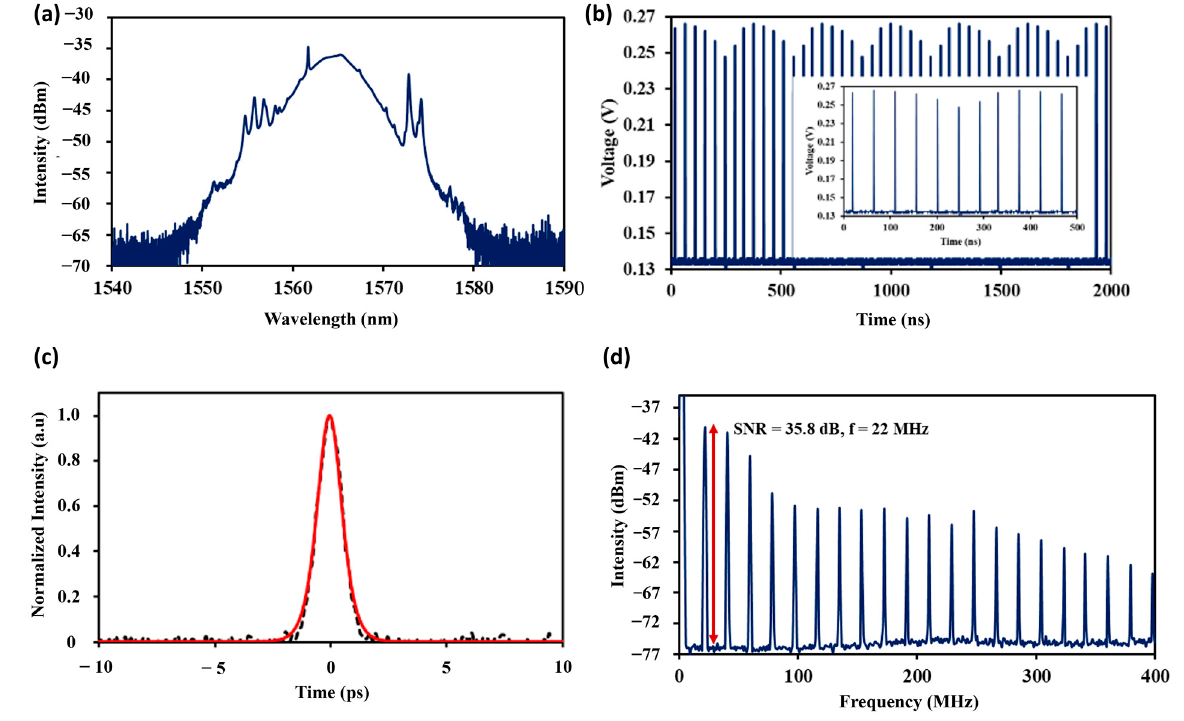
Figure 3. ( a ) Characteristics of the soliton mode-locked pulse at pump power of 110.8 mW; ( a ) optical spectrum at OSA; ( b ) typical pulse train at oscilloscope; ( c ) pulse width measurement with auto-correlator trace; ( d ) RF spectrum with RF spectrum analyzer.